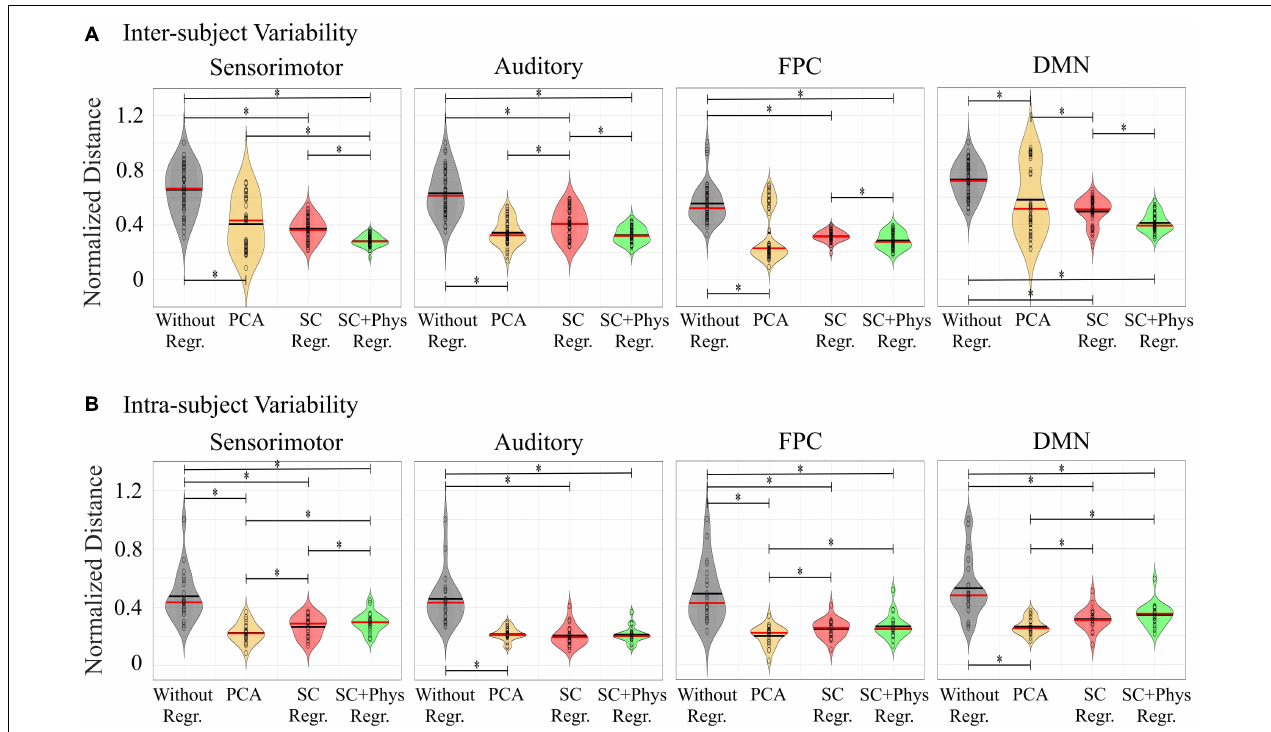
FIGURE 6 | Violin plots with (A) inter- and (B) intra-subject variability estimated through the Euclidian distance among networks from pairs of participants. The red and black lines inside each violin are the median and mean values, respectively. The black circles are actual values. To verify the impact of each preprocessing approach on the inter- and intra-subject variability, we normalized the distances by the maximum values across all preprocessing approaches within each network. ( ∗ ) denotes pairs of variability distributions statistically different ( p < 0.05) from each other assessed with a two-sided t -test.